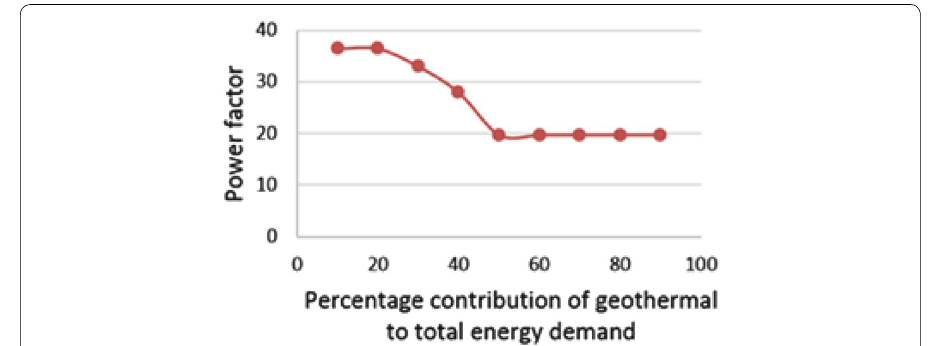
Fig. 14 Power factor versus percentage contribution of geothermal energy to the total energy